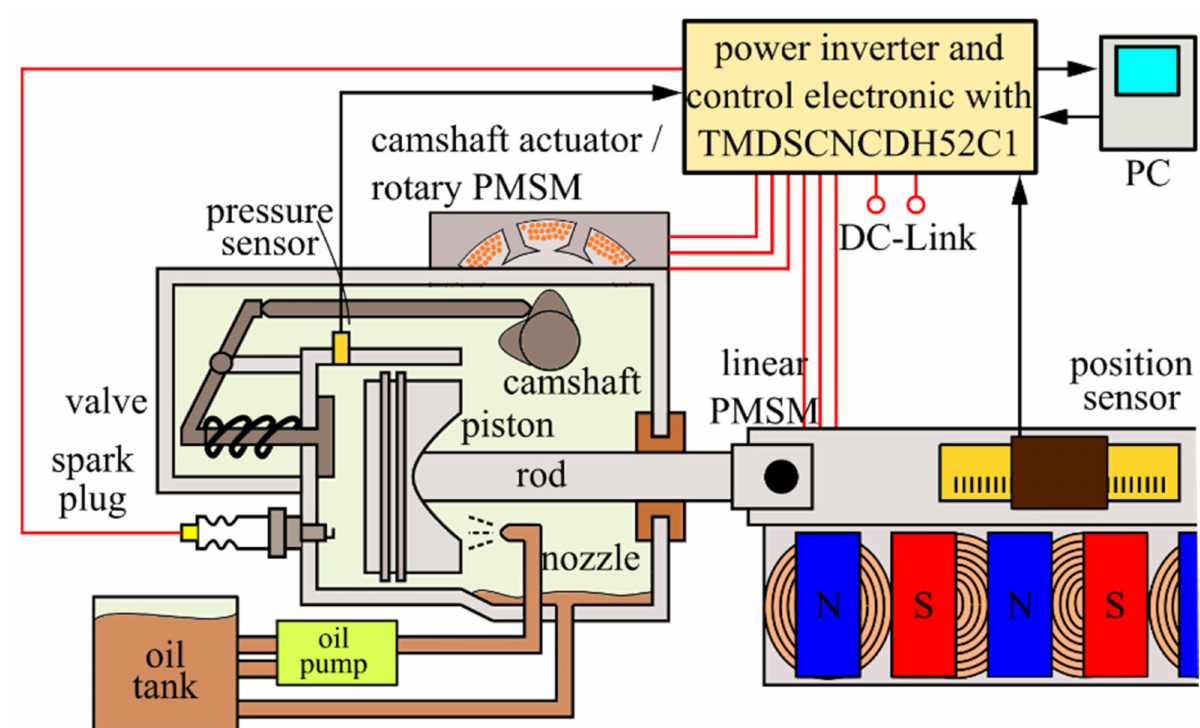
Figure 2. Schematic representation of the free-piston